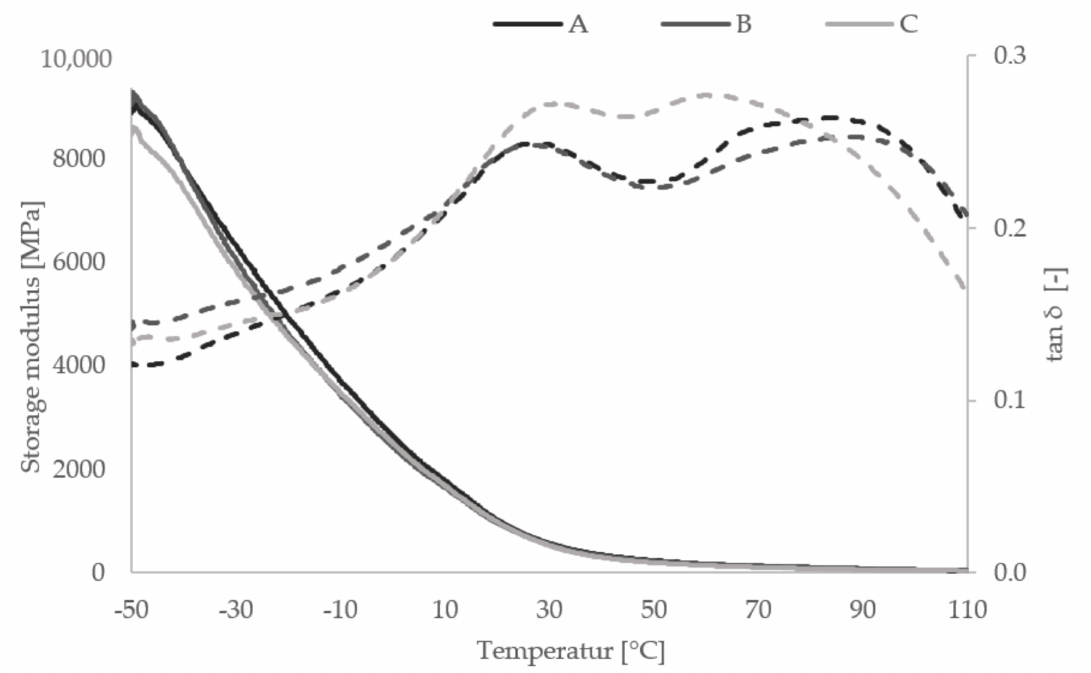
Figure 9. Results of the dynamical mechanical analysis (DMA) measurements. Means of storage moduli (continuous line) and tan δ (dashed line) for groups A, B, and C.